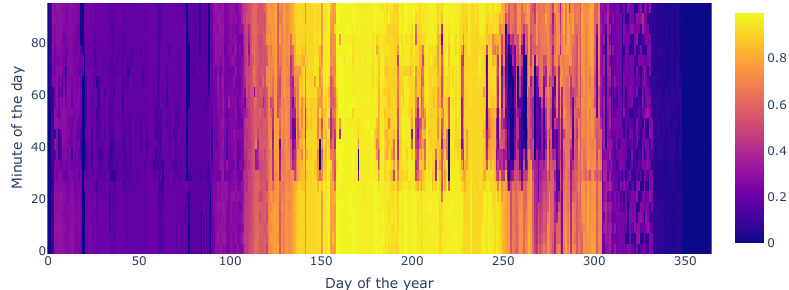
Figure 8. Hydroelectric power profiles.